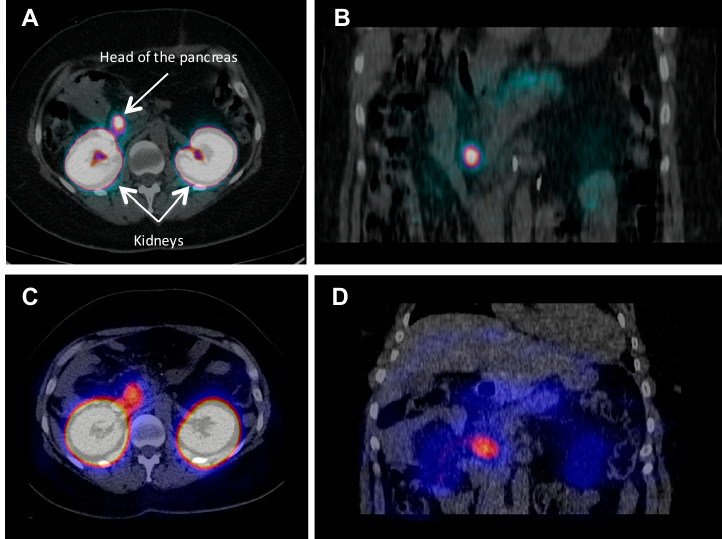
Figure 3. ( A ) Transaxial and ( B ) Coronal PET/CT images obtained 2.5 h after injection of 80 MBq [Nle 14 ,Lys 40 (Ahx-DOTA- 68 Ga)NH 2 ]-exendin-4; ( C ) Transaxial and ( D ) Coronal SPECT/CT images of the same patient obtained 72 h after injection of 92 MBq [Nle 14 ,Lys 40 (Ahx-DOTA- 111 In)NH 2 ]-exendin-4. Focal uptake is seen in the head of the pancreas. Courtesy of Dr. Kwadwo Antwi, University Hospital of Basel, Switzerland.